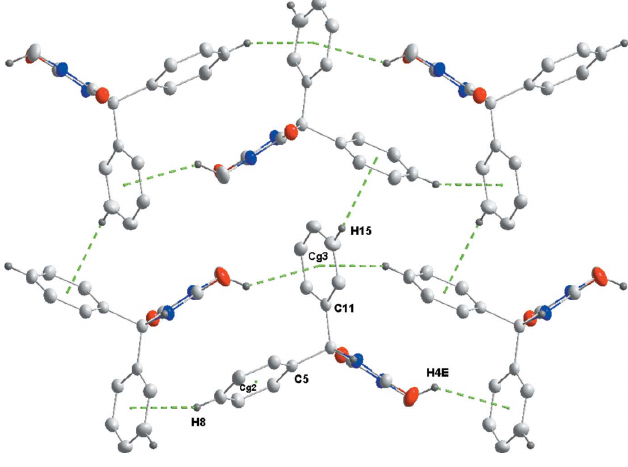
Figure 2 C—H (cid:3)(cid:3)(cid:3) (cid:2) (ring) contacts in the title structure, shown as green dashed lines.